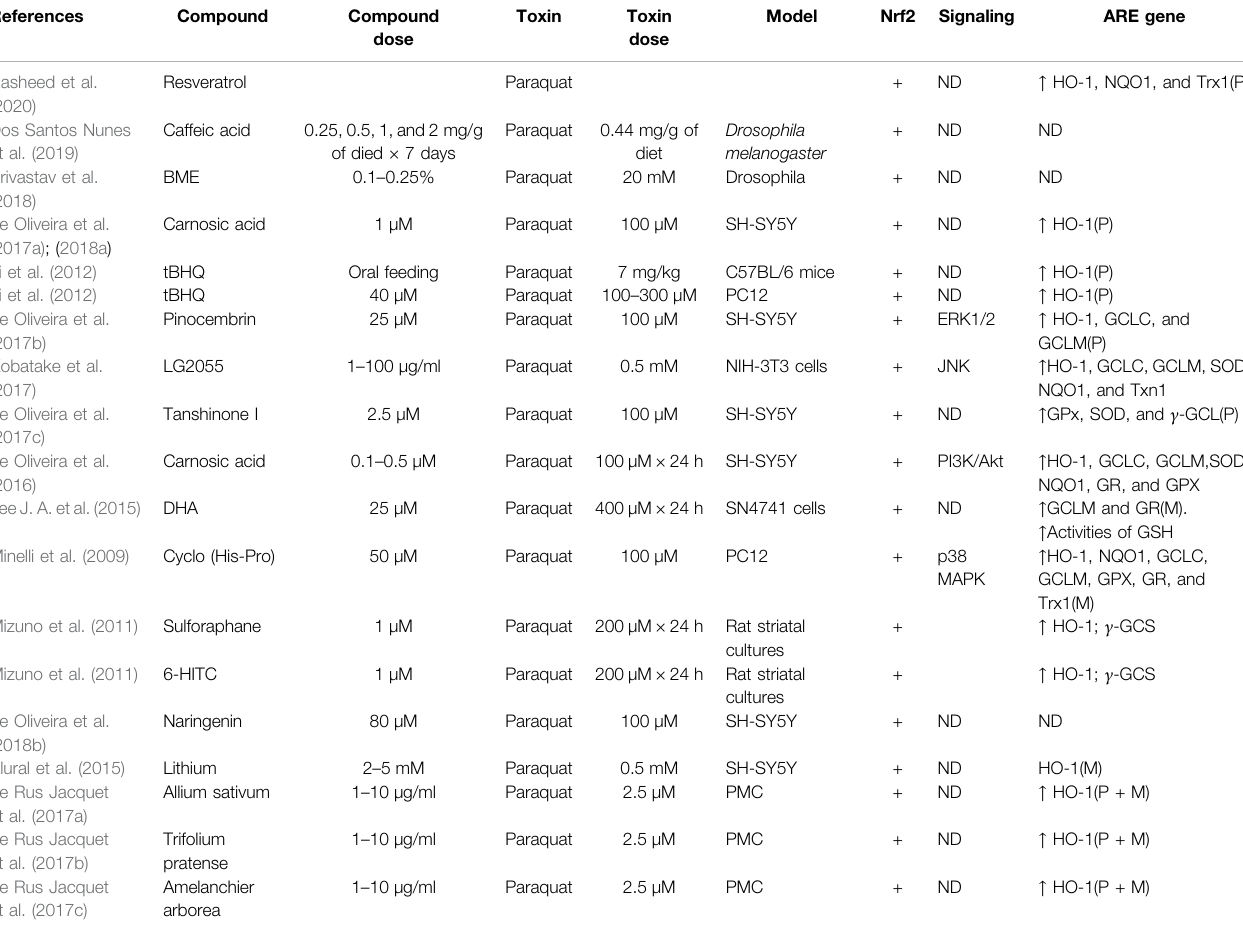
TABLE 5 | Summary of the experimental studies involving compounds able to modulate Nrf2 pathway in paraquat-induced PD